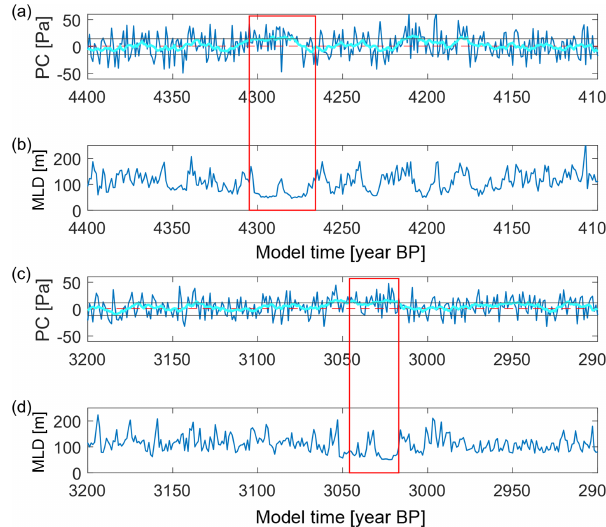
Figure 8. Leading principal component (PC) of the sea-level pres- sure over the Atlantic sector north of 35 ◦ N for (a) event 1 during winter (DJF) and (c) event 2 during spring (MAM). The respective 10-year-running means are indicated by the light blue lines. Annual mixed-layer depth (MLD) for event 1 (b) and event 2 (d) are shown. The red boxes indicate the time span of the events. The gray lines in (a) and (c) indicate the 2 σ interval of the 10-year-running means of the corresponding